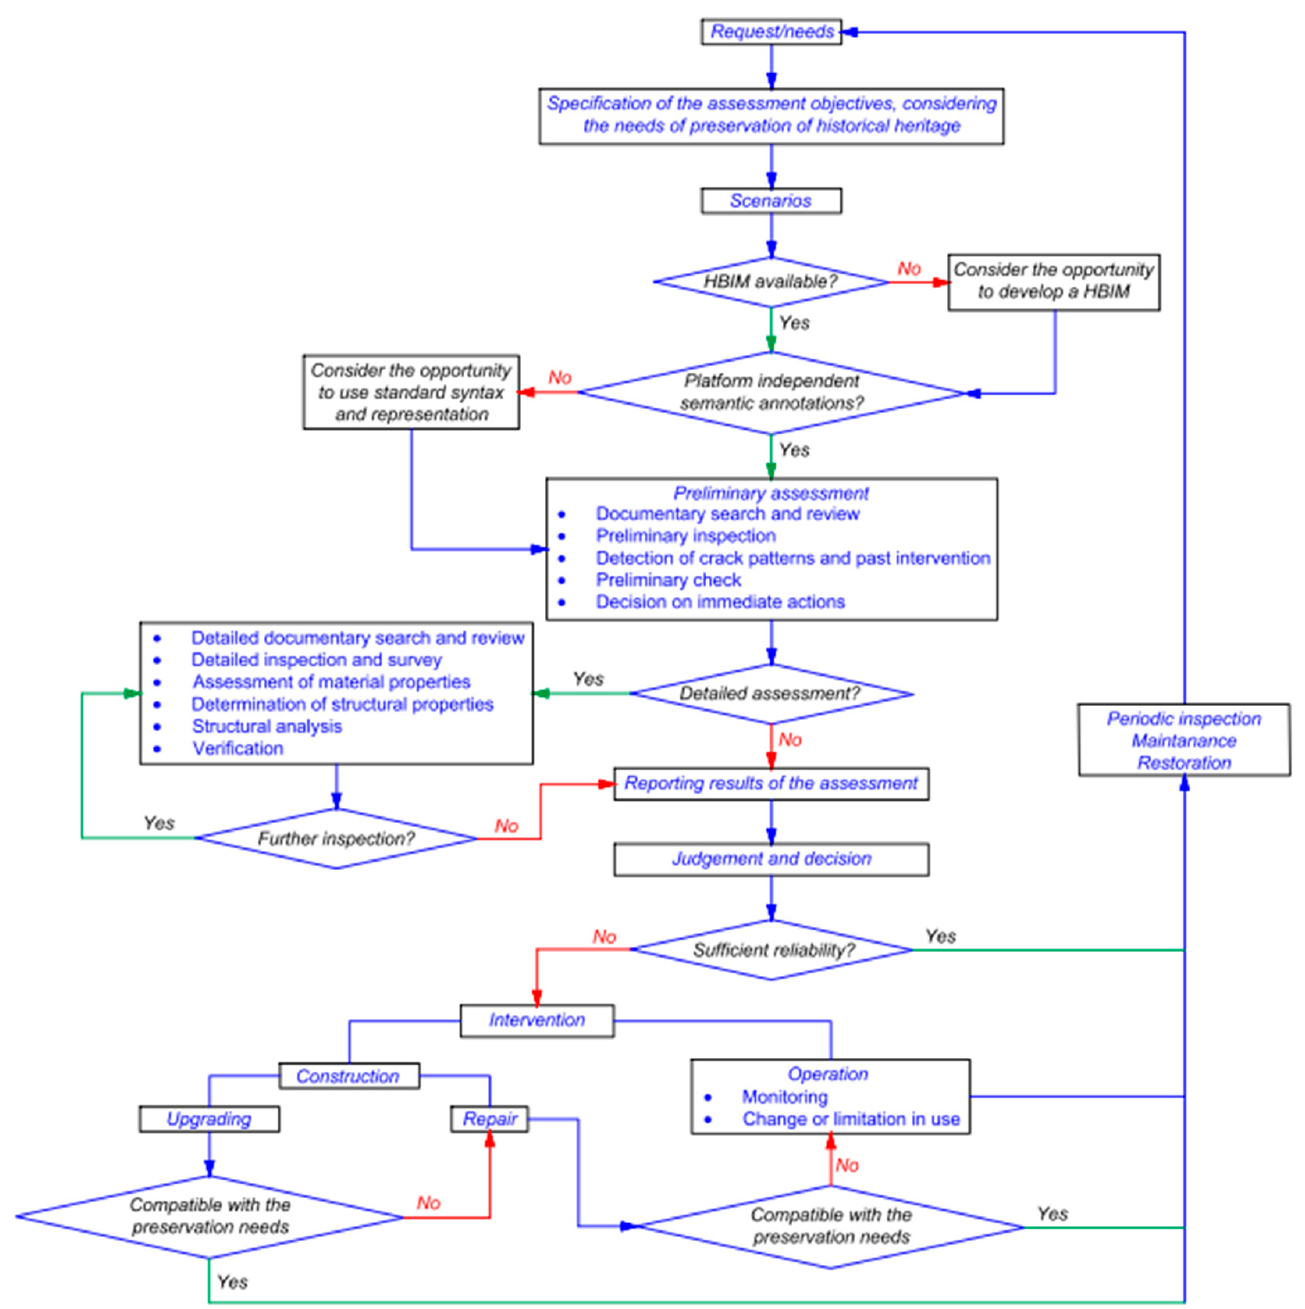
Figure 1. Flowchart illustrating the assessment procedure of heritage structures.